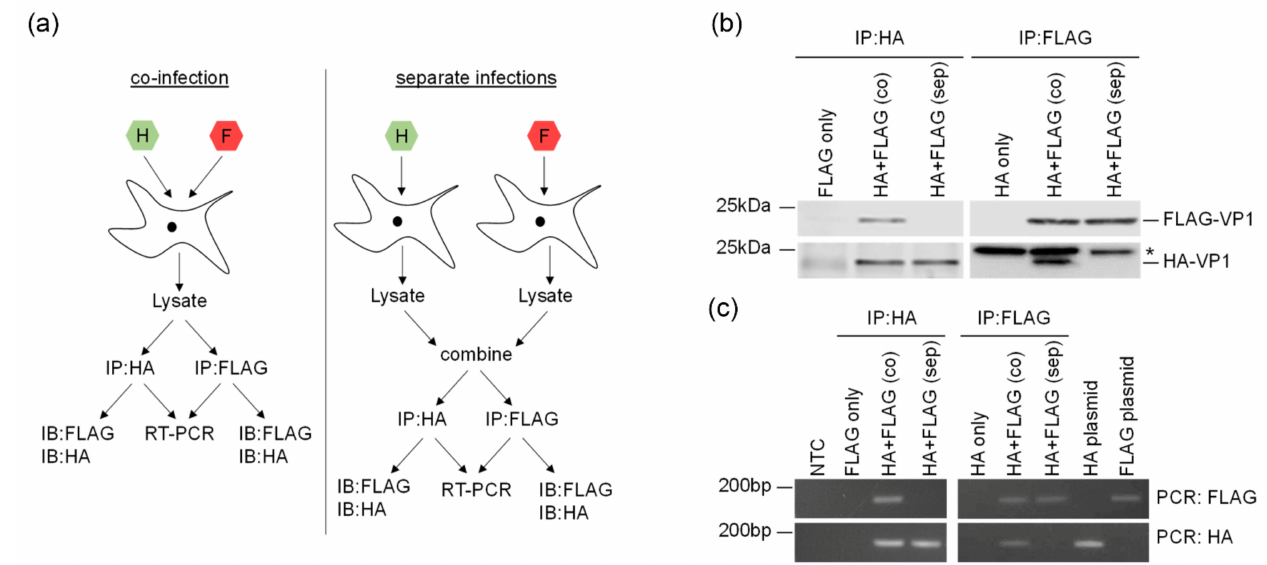
Figure 4. Co-infection results in chimeric capsids and trans-encapsidation of viral genomes. ( a ) Schematic diagram outlining the workflow for the immunoprecipitation experiments. Cells were either co-infected with HA-FMDV O1K/O UKG35 (H) and FLAG-FMDV O1K/O UKG35 (F) or infected with each virus separately. Lysates from co-infected cells were immunoprecipitated using anti-HA affinity gel (IP:HA) or anti-FLAG affinity gel (IP:FLAG), and each immunoprecipitate was split into two aliquots for immunoblot analysis (IB) and RT-PCR. Lysates from cells separately infected with either HA- or FLAG-tagged FMDV were mixed 1:1 and subjected to the same procedure. Lysates from single infections were also used as controls. ( b ) HA and FLAG immunoprecipitates from single infections, co-infections (co) or combined lysates from separate infections (sep) were analysed by immunoblotting for the presence of FLAG- and HA-tagged VP1. * = IgG. ( c ) HA and FLAG immunoprecipitates from single infections, co-infections (co) or combined lysates from separate infections (sep) were subjected to RT-PCR using FLAG- or HA-specific primer sets. Infectious copy plasmids containing HA- or FLAG-tagged viral sequences served as controls. NTC = no template